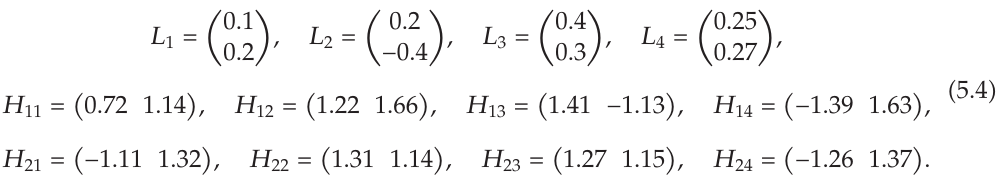
Table 1: The maximal allowable delays τ Case I II τ 13 0.80 0.75 0.70 0.65 0.60 0.75 0.80 0.85 0.90 0.95 τ